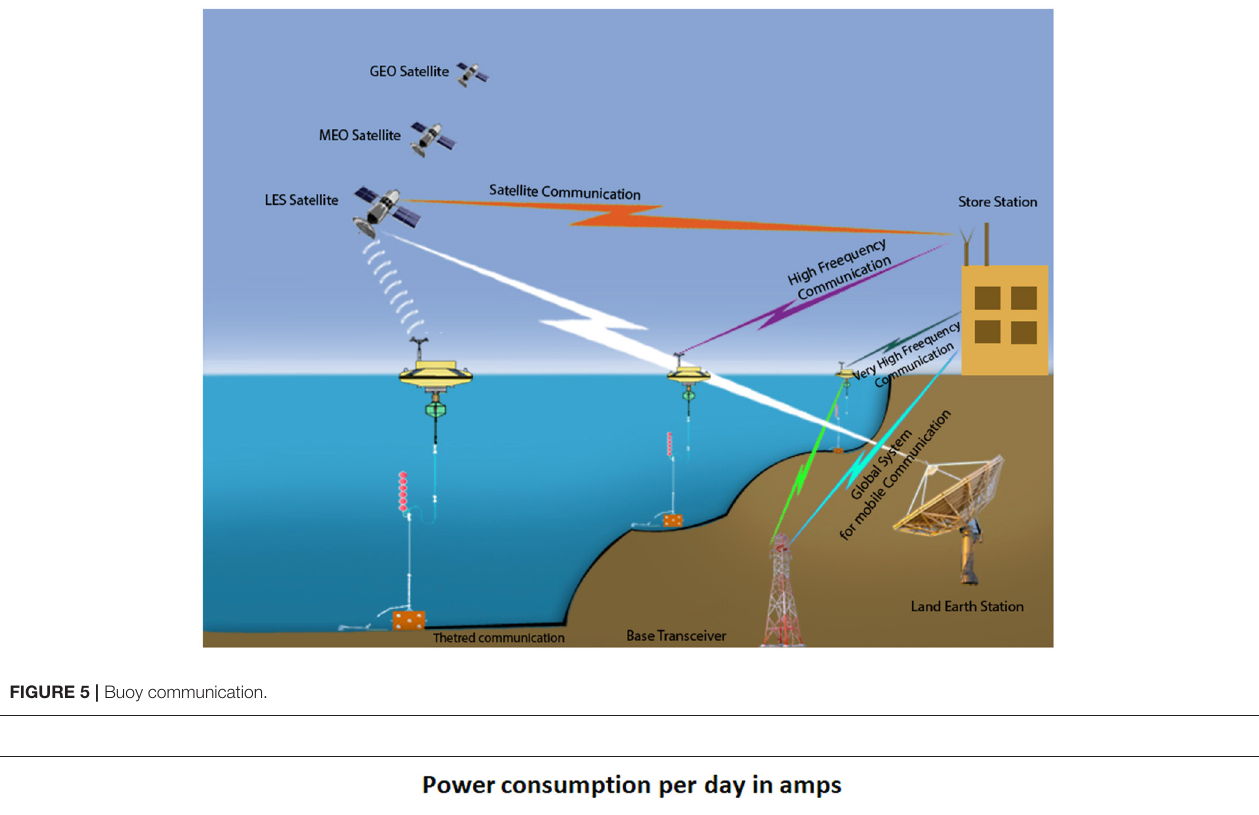
FIGURE 5 | Buoy communication.